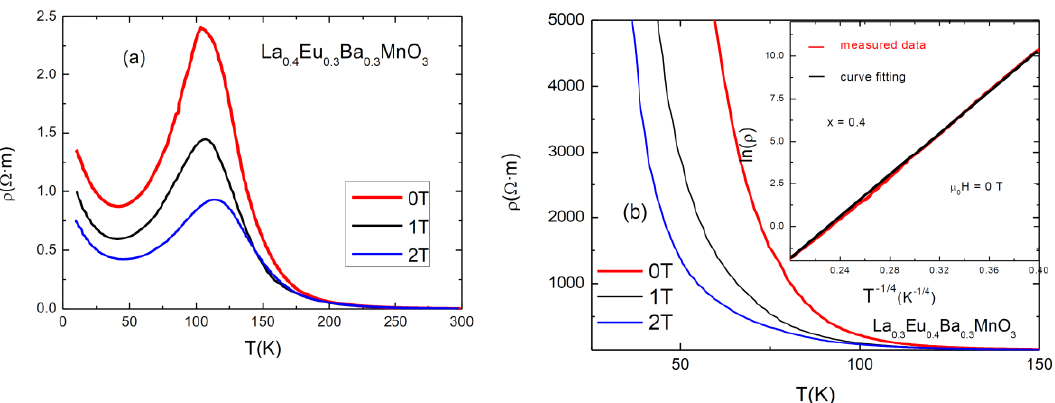
Figure 5. Resistivity vs. temperature graphs for ( a ) x = 0.3 and ( b ) x = 0.4. The inset shows the fitting of ln(ρ) as a function of T − 1/4 for μ 0 H = 0 T. From the values for resistivity (ρ peak ) and magnetoresistance ( MR Max ) in Table 4, it is Table 4. Experimental values for La 0.7 − x Eu x Ba 0.3 MnO 3 bulk materials: electrical eviden, that both of them tend to increase with increasing substitution level of Eu. The maximum observed resistivity for the x = 0.3 sample is 240 Ω ٠ cm and ( MR Max ) (2 T) = 63.6%, while the resistivity increases to several orders of M Ω · m for x = 0.4.